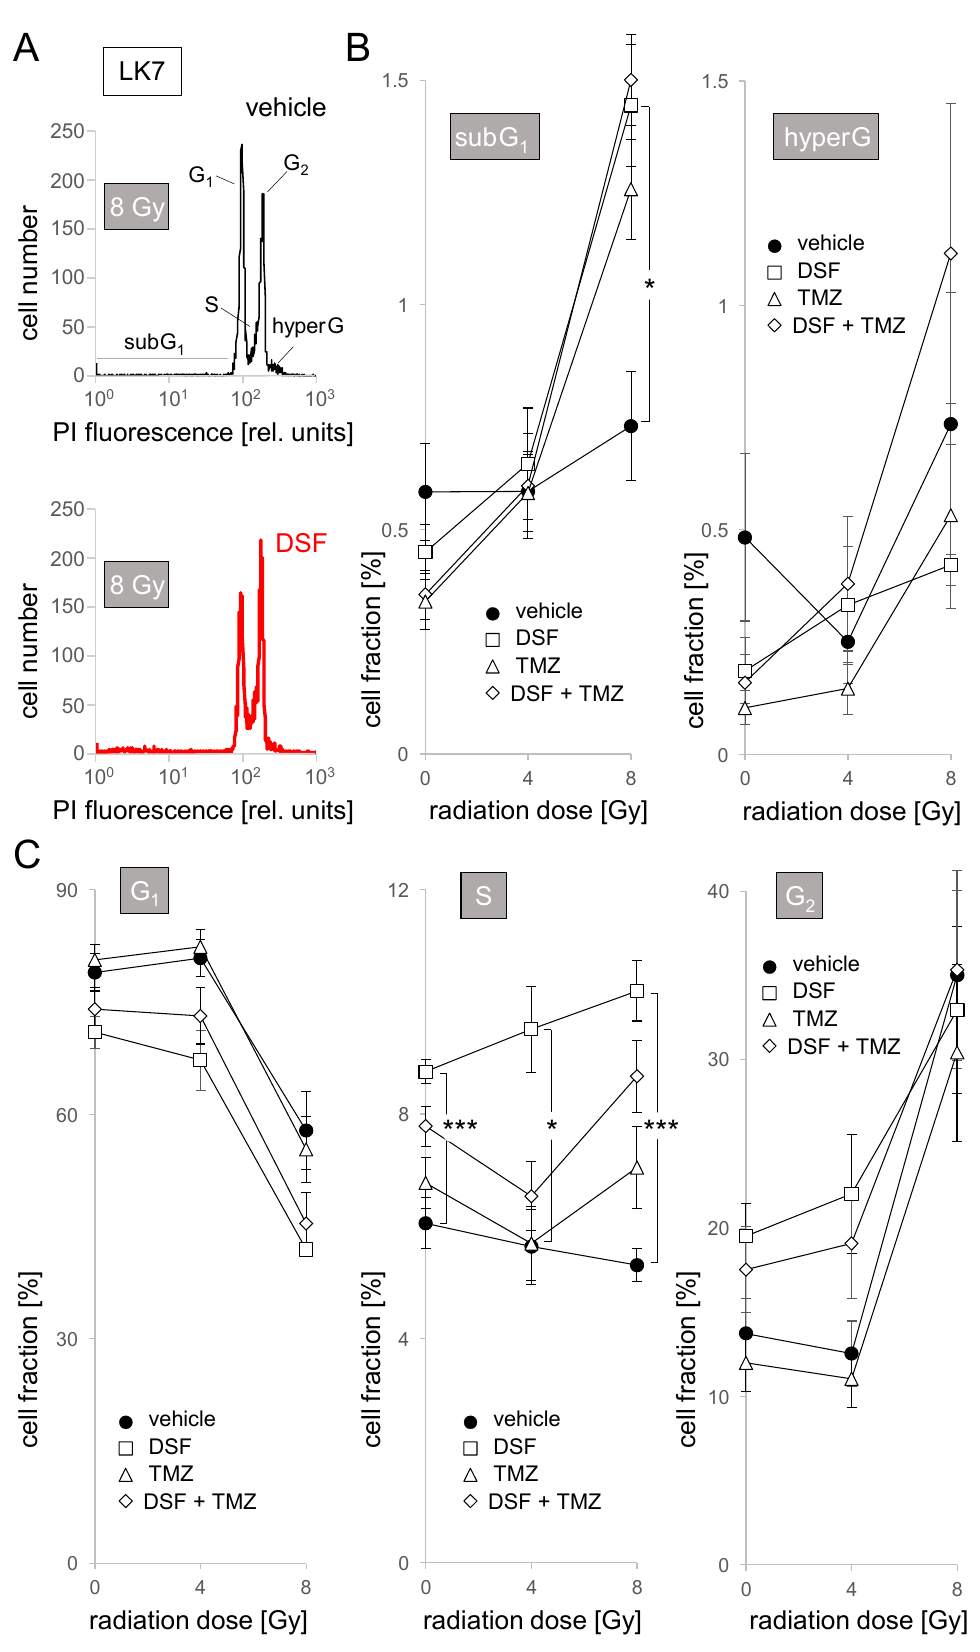
Figure 4. Disulfiram increases S population in LK7 cells. ( A ) Representative flow cytometry histograms showing the distribution of the DNA-specific propidium iodide (PI) fluorescence among vehicle (black) or DSF (100 nM, red) cotreated LK7 cells 48 h after irradiation with 8 Gy. ( B , C ) Depend- ence of the mean (±SE, n = 9) percentage of dead cells (subG 1 population, ( B ), left), and of cells with polyploidy/polynuclearity (hyperG population, ( B ), right), as well as of cells in G 1 (( C ), left), S (( C ), middle) and G 2 (( C ), right) phase of cell cycle on radiation dose and cotreatment with vehicle (closed circles), disulfiram (DSF, 100 nM, open squares), temozolomide (TMZ, 30 µM, open triangles) and